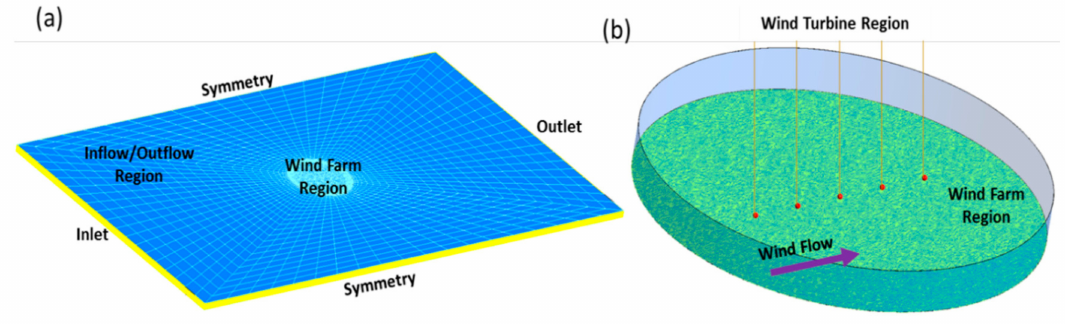
Figure 2. ( a )Thecomputationaldomainmeshlayoutandboundaryconditionsand( b